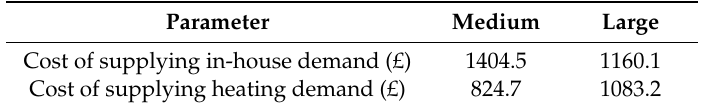
Table 6. Electricity cost composition for the heat pump in the long run electricity price regime. Parameter